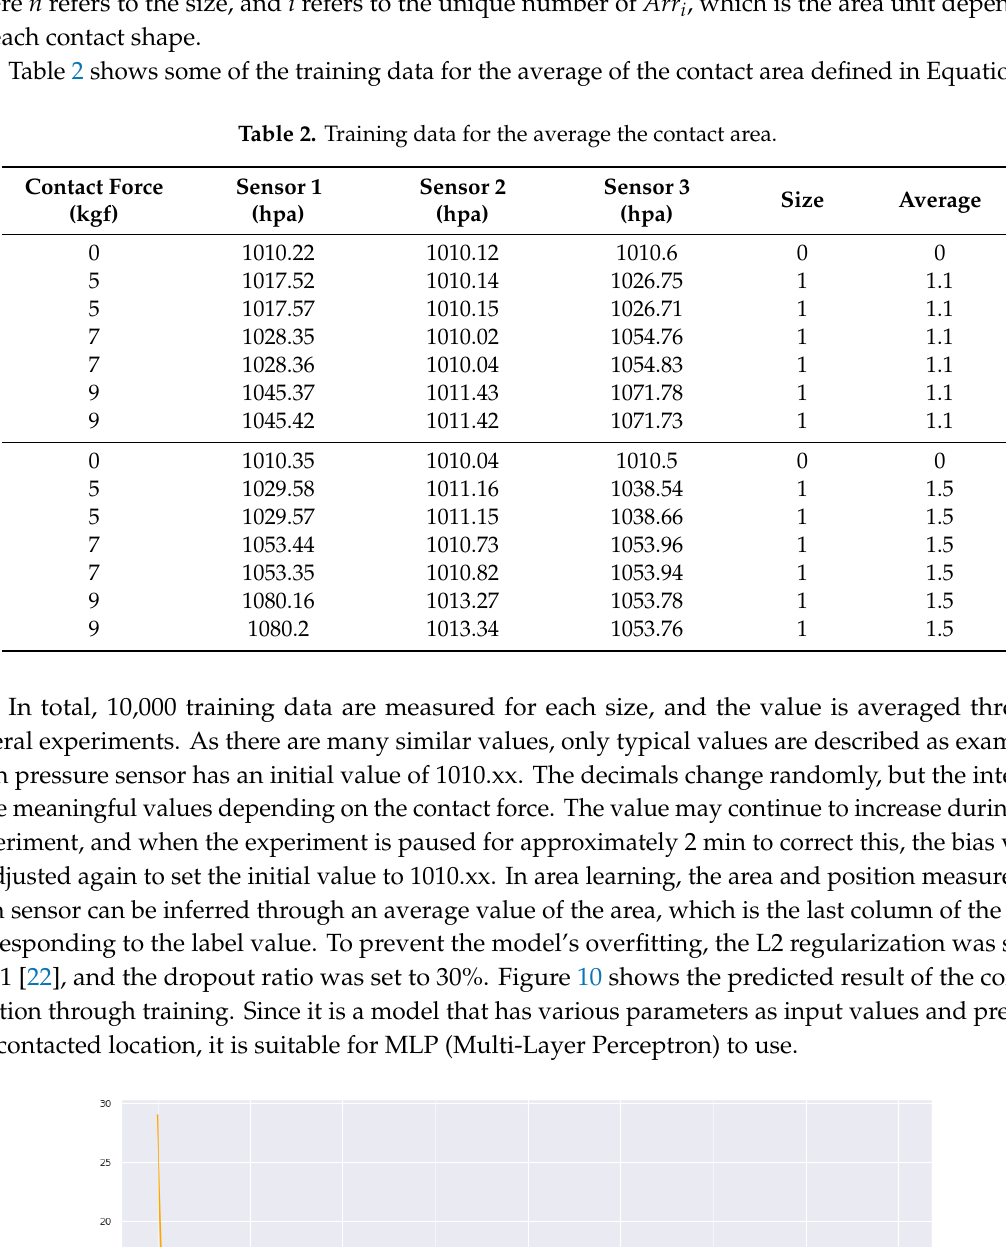
Table 2. Training data for the average the contact area.